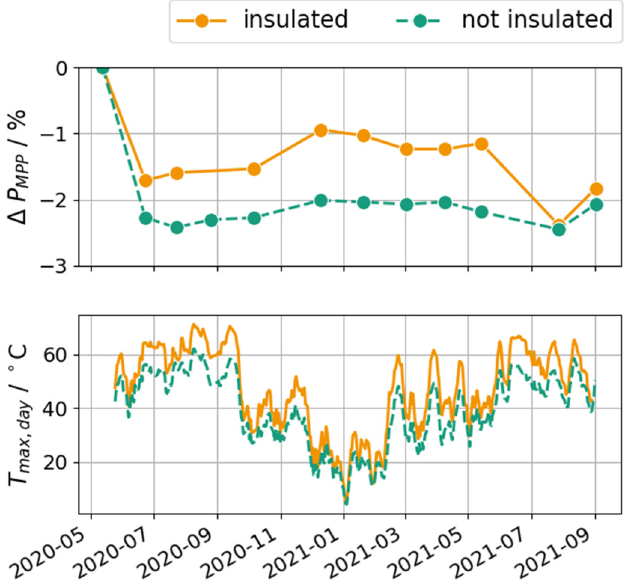
Fig. 14. Performance change over time of two mono-crystalline PERC modules during 15 months of outdoor exposure (top). Weekly average of the daily maximum module temperature